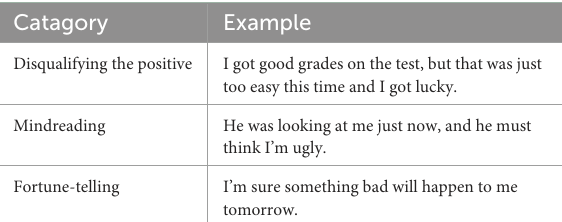
TABLE 1 These are examples of cognitive